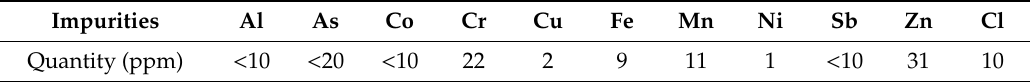
Table 1. Impurities in MgZr (data supplied by